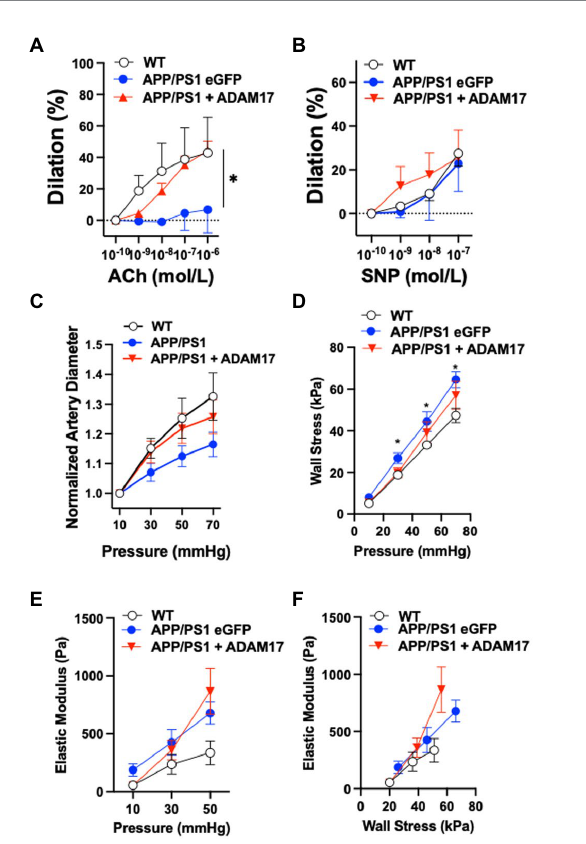
FIGURE 6 ADAM17 re-expression improves cerebral arteriole vasodilator function in APP/PS1 mice. (A) ADAM17 overexpressed APP/PS1 mice show an improved vasodilation in response to acetylcholine (ACh) in isolated basilar arteries compared to eGFP overexpressed APP/PS1 mice, which have a decreased dilatory response compared to the WT control mice. (B) There were no differences seen in the dilatory responses to sodium nitroprusside (SNP) in isolated basilar arteries of WT, eGFP, or ADAM17 overexpressed APP/PS1 mice. (C) Normalized (to 10 mmHg) diameter of arterioles in calcium free solution in response to incremental increases to intraluminal pressure (10 to 70 in 20 mmHg increments). (D–F) Calculated circumferential wall stress, incremental elastic modules and elastic modulus wall stress relationships in WT, eGFP-or ADAM17-overexpressed APP/PS1 mice. n =3 − 6 mice per group. * p < 0.05 WT, ADAM17 vs eGFP APP/PS1. Two way ANOVA was